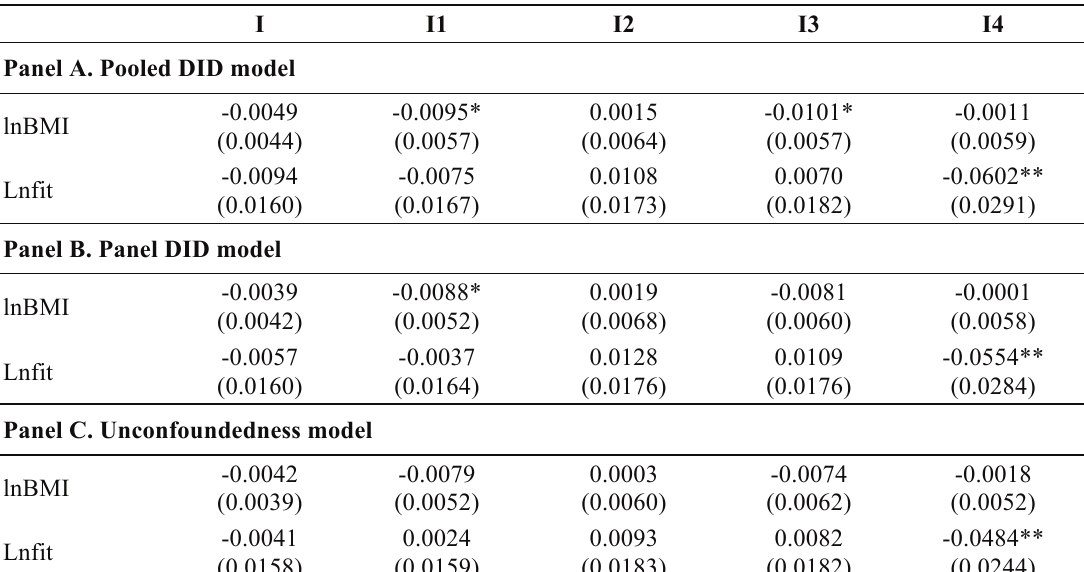
Table 3. Estimated health effect of the interventions I I1 I2 I3 I4 Panel A. Pooled DID model